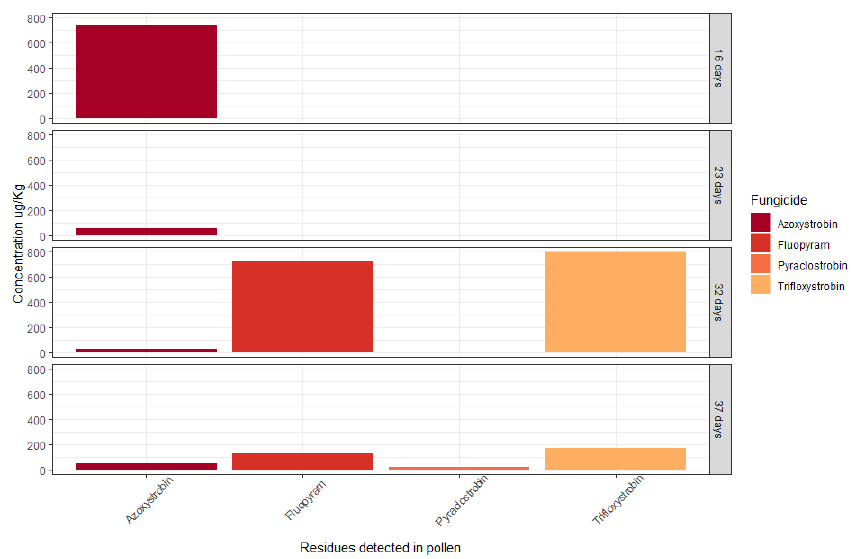
Figure 4. Concentrations ( µ g/Kg) of four fungicides detected in composite pollen sampled from hives situated in almond at 16, 23, 32, and 37 days after placement.